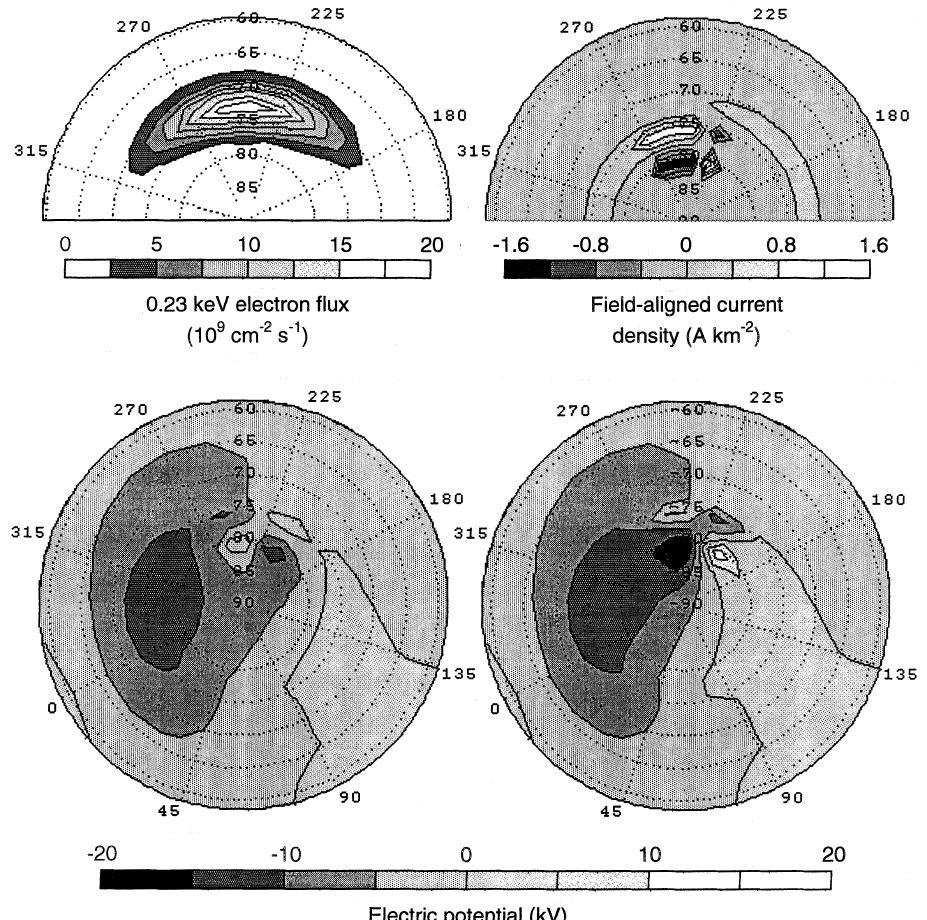
Fig. 1. Top panel : geomagnetic polar plots (latitudes 60 (cid:176) –90 (cid:176) ) of the input precipitation flux of 0.23 keV electrons ( left plot ) and input field- aligned current density ( right plot ) in the Northern Hemisphere at 0030 UT which is the time of maximum of the disturbance (variant 1